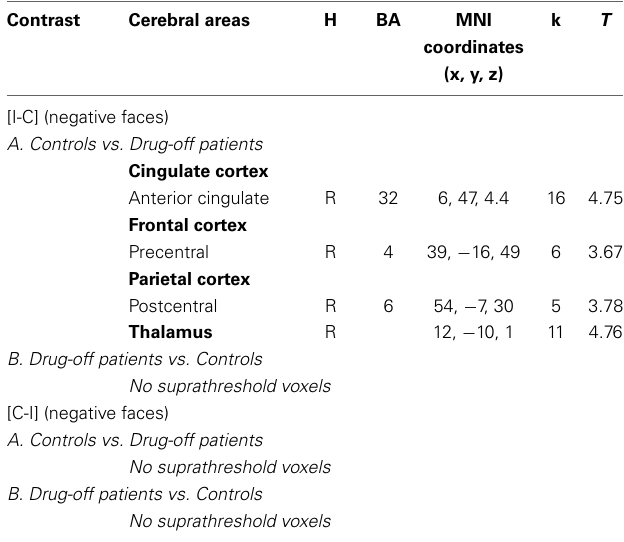
Table 8 | Comparisons between controls and drug-off patients: brain regions activated during the emotional Stroop task with negative